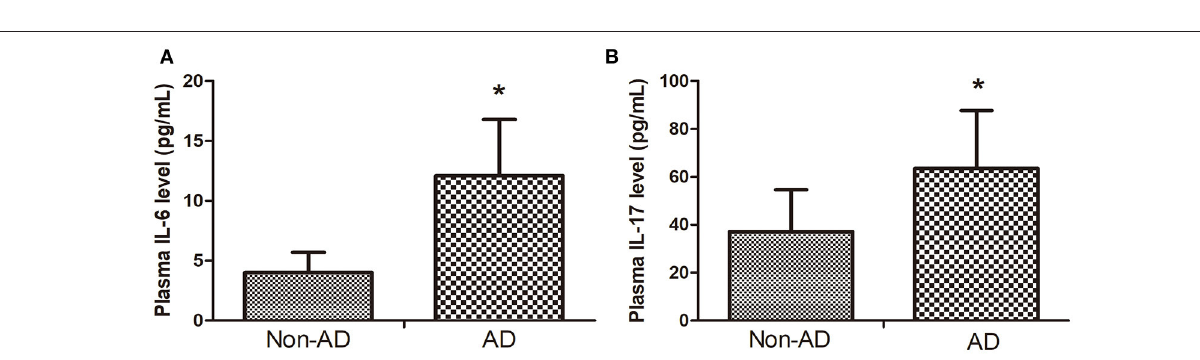
− 0.37, p < 0.05, and r = − 0.42, p < 0.05,